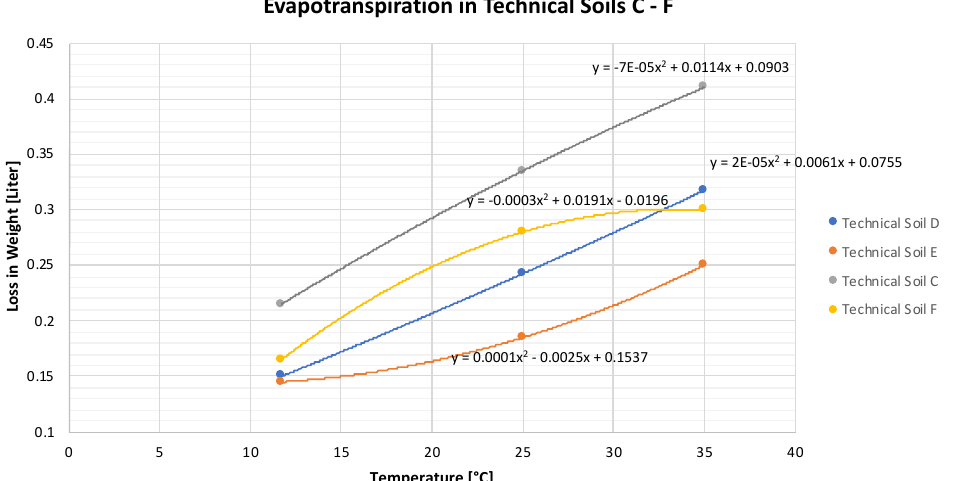
Figure 3. Regression lines were inserted through the differences in weight of any soil combination of technical soil B (with and without planting) in climate scenario I, II, and III, to create equations for calculating evapotranspiration (based on Weiss, 2017 [40]).